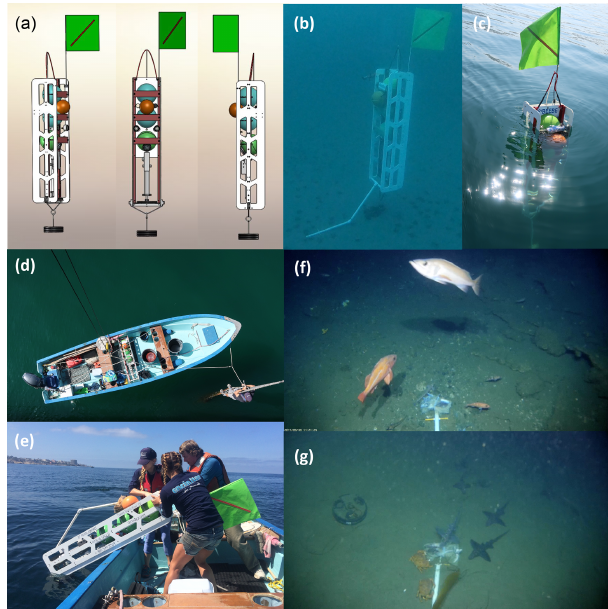
Figure 1. DOV BEEBE is an autonomous, hand-deployable Nanolander capable of operating to 1000m of depth. It is outfit- ted with a Sea-Bird MicroCAT-ODO environmental sensor for col- lecting high-frequency measurements of near-seafloor temperature, oxygen, salinity, and pressure, as well as a camera and light system for collecting videos of seafloor communities. (a) Front and side views showing the general design for DOV BEEBE (see additional details in Fig. 2). DOV BEEBE is shown deployed at 30m of depth in (b) and floating at the surface in (c) prior to recovery. BEEBE can easily be deployed and recovered by hand from a small boat by as few as two people (d, e) . Examples of the field of view from the BEEBE camera system taken from (f) D100-DM-Fall at ∼ 100m off Del Mar Steeples Reef showing various rockfish species (genus Sebastes ) and (g) D200-LJ-2 at ∼ 200m near the Scripps Reserve showing the presence of cancer crabs and chimaeras. The drop arm with the bait bag can be seen in the camera field of